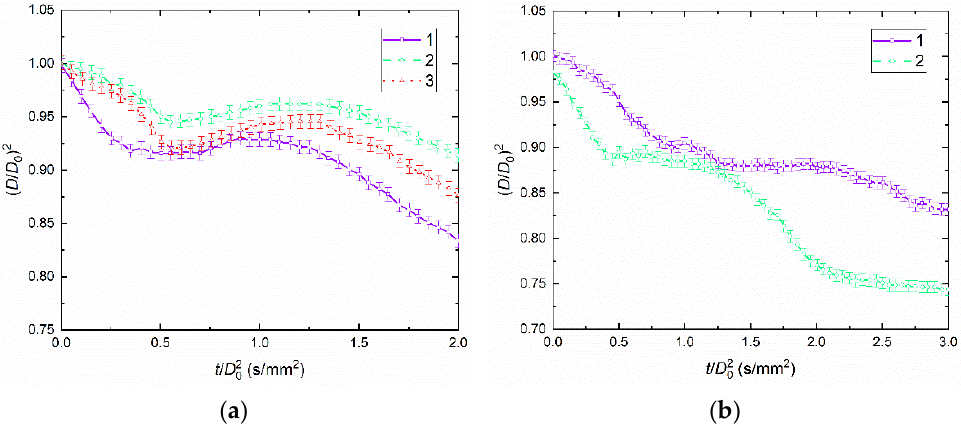
Figure 6. Temporal characteristics of droplet evaporation and drying until breakup for blends K50W50 ( a ) and C50W49LI1 ( b ) ( R d0 = 1.3 ± 0.1 mm): 1 — T a = 950 ± 30 K; 2 — T a = 1050 ± 30 K; 3 — T a = 1150 ± 30 K.